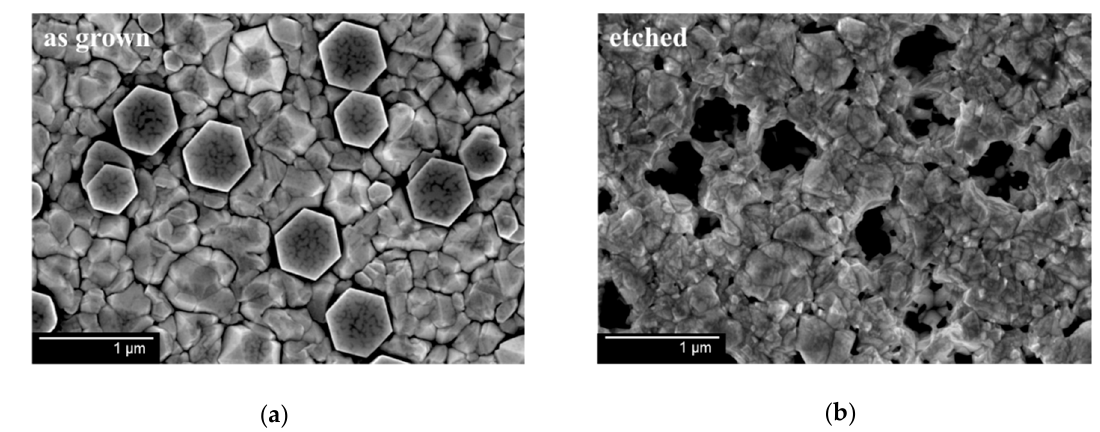
Figure 3. SEM images in the plane-view of the same NW array, before ( a ) and after ( b ) KOH treatment. Before KOH treatment, two kinds of NWs—those with flat hexagonal tops and those with rounded edges—were visible. After etching, the hexagonal ones disappeared, while the oval-top NWs remained untouched.